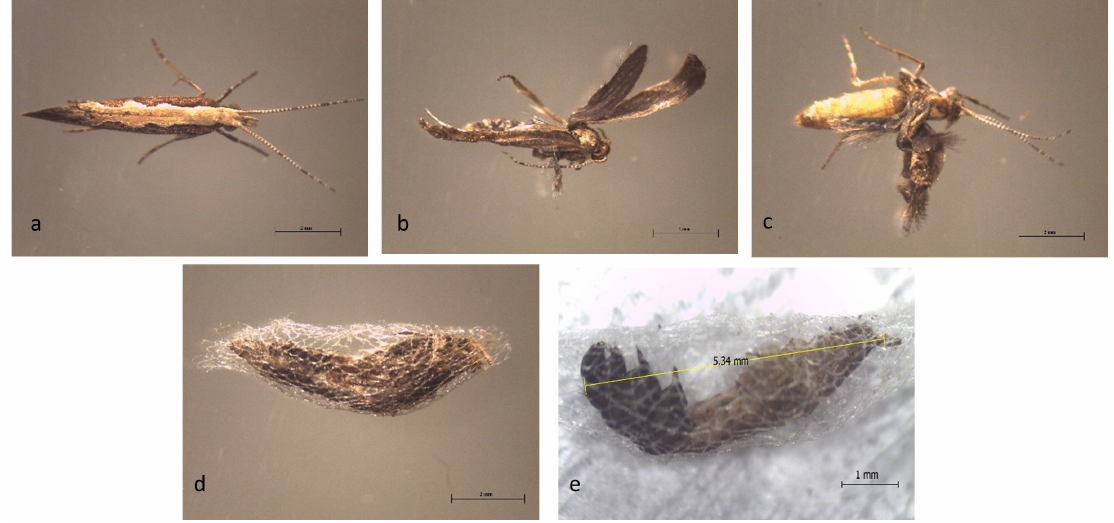
Figure 2. Morphological abnormalities in treated P. xylostella with sublethal concentration of farnesyl acetate at adult and pupal stages: ( a ) normal adult; ( b , c ) adult with twisted wings; ( d ) adult trapped in the cocoon; ( e ) larvae–pupae intermediates; scale bar: 1